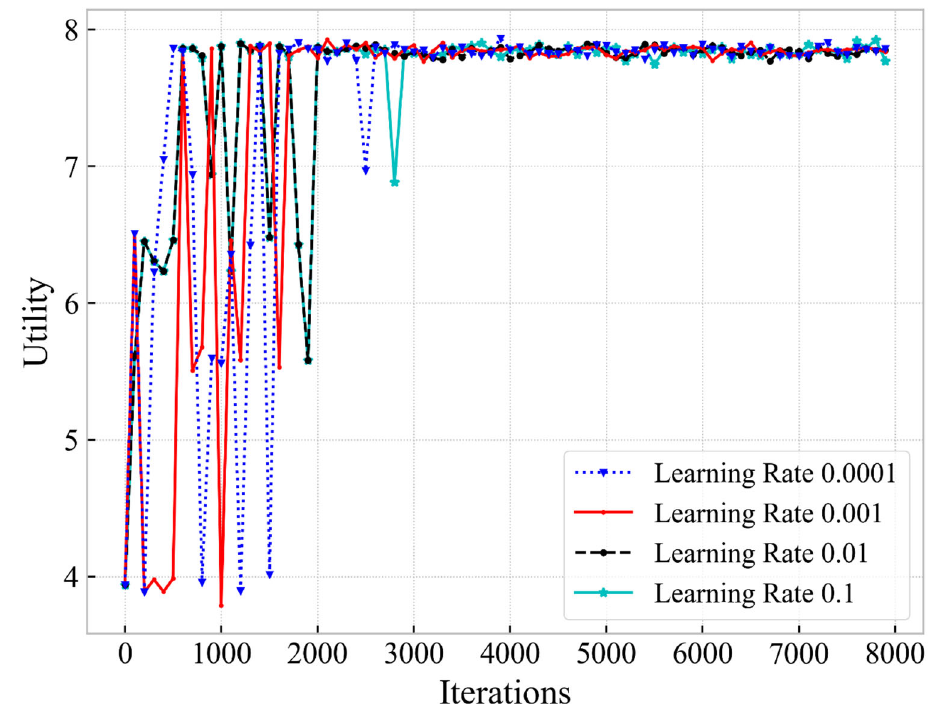
Figure 14. Comparison of algorithm performance with different learning rates.